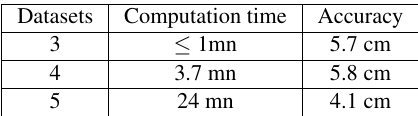
Table 2: ”cloud-to-triangular mesh” Method: Accuracy